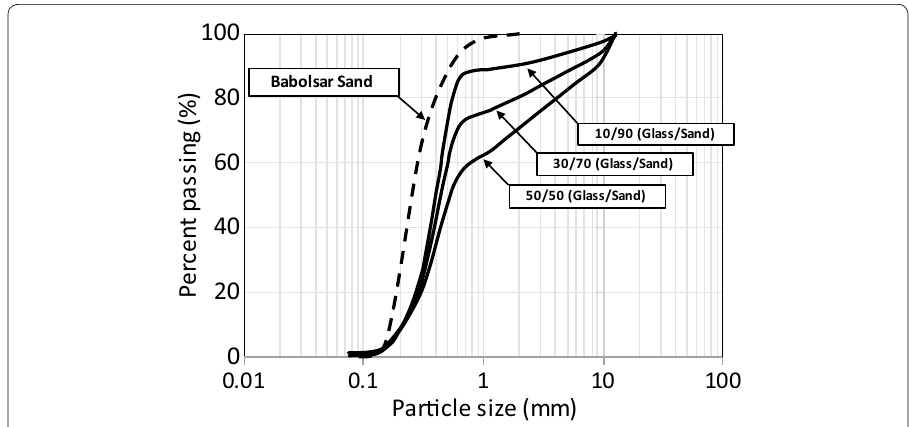
Fig. 1 Grain size distribution for CG, SM and CG–SM blends